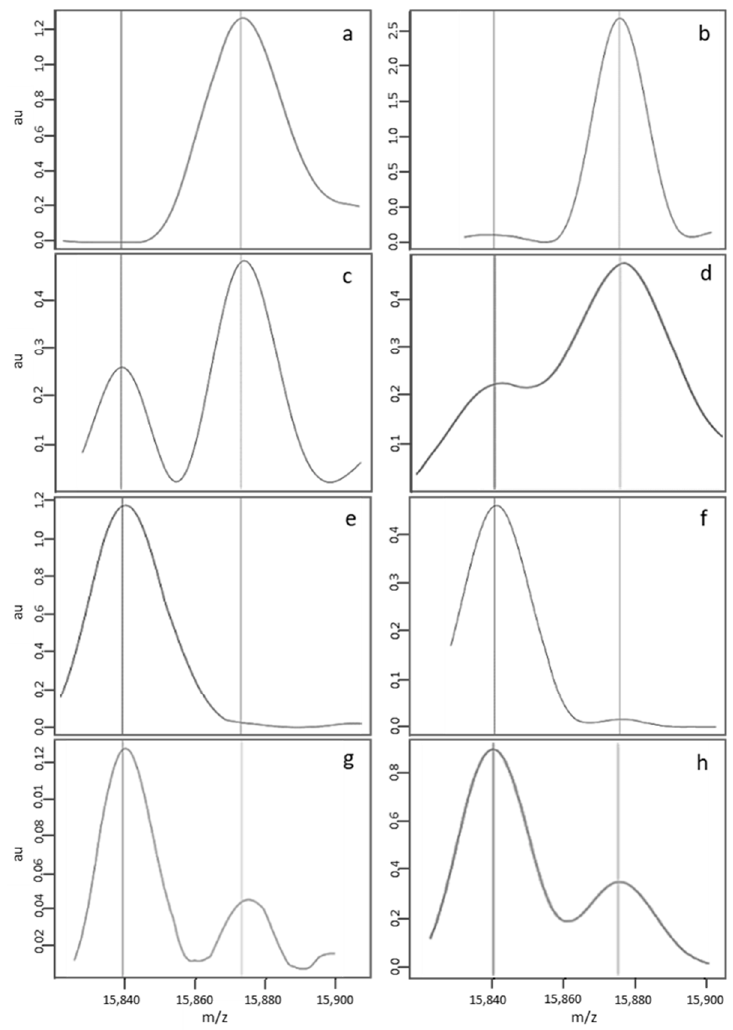
Figure 2. Examples of standard MS profiles correctly classified by the NeoSickle ® software, from newborns with the following phenotypes: FA ( a , b ), FAS ( c , d ), FS ( e , f ) and S- β + ( g , h ). 3.2.2. Classification by the Algorithm of “Standard” Profiles, as a Function of the Newborn’s